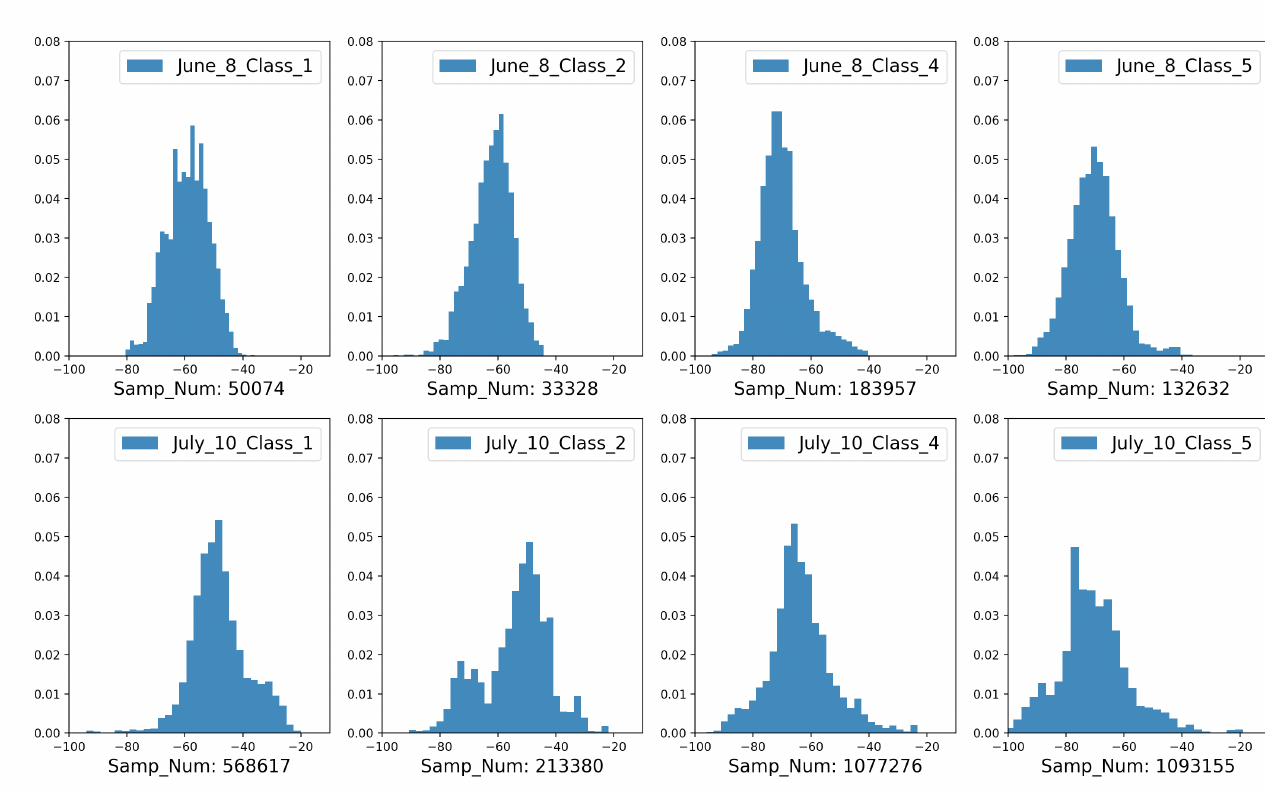
Figure 4. Distribution of pre-processed BT-RSSI values regarding four classes (Class 1: below 1 m, Class 2: 1.5–2.0 m, Class 4: around 3 m, class 5: beyond 5